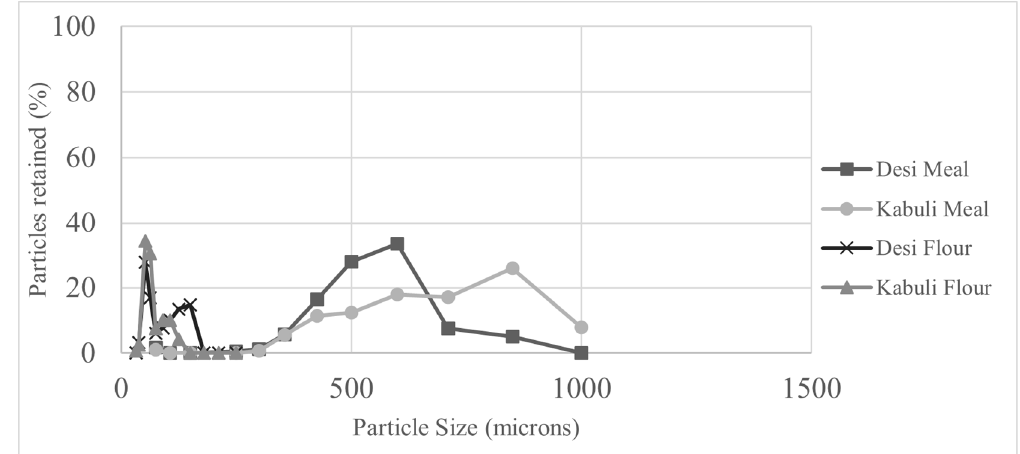
Table 4. Proximate Analysis of kabuli and desi